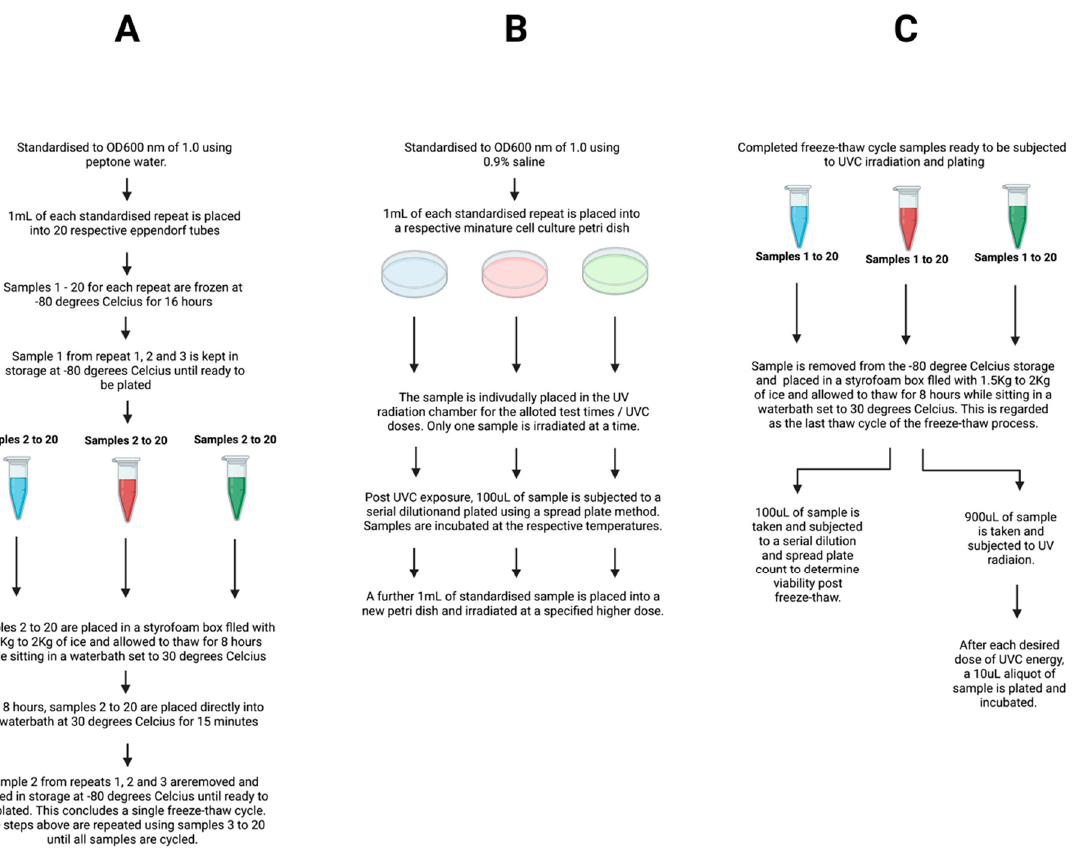
Figure 1. Schematic of the experimental workflow for the freeze-thaw process ( A ), the UVC radiation process ( B ) and the combined freeze-thaw and UVC radiation process ( C ).